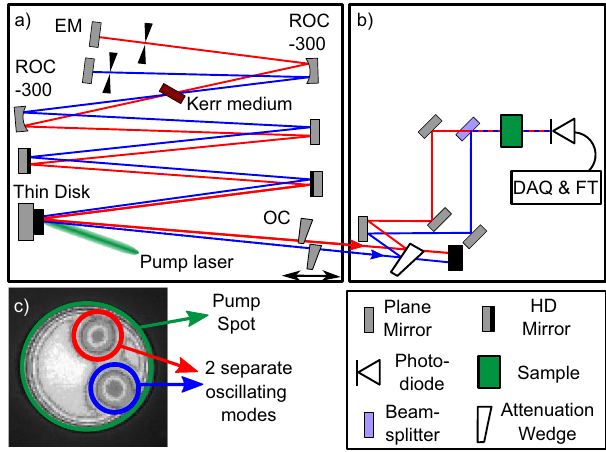
Fig. 1 Schematic drawing of the dual-comb thin-disk laser system. a The laser is based on the Yb:YAG thin-disk resonator. The beam-paths corresponding to the “ red ” and “ blue ” beams are separated in tangential plane for illustration only. EM end mirror, ROC radius of curvature, OC output coupler (10 % transmission). b The heterodyne detection setup. DAQ data acquisition board, FT Fourier transform. c Image of the pump spot (laser active area) on the thin disk. Both laser modes share a single pump spot and therefore a single pump laser. They show a slight horizontal displacement that is a result of the optimized